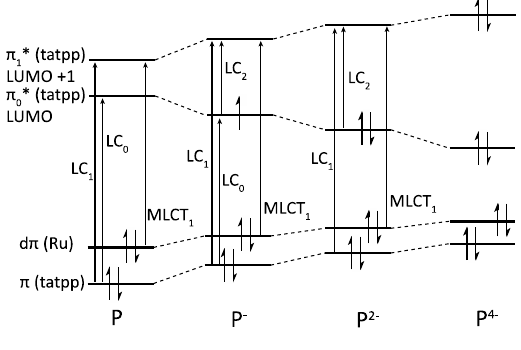
(tatpp)Ru(phen) 2